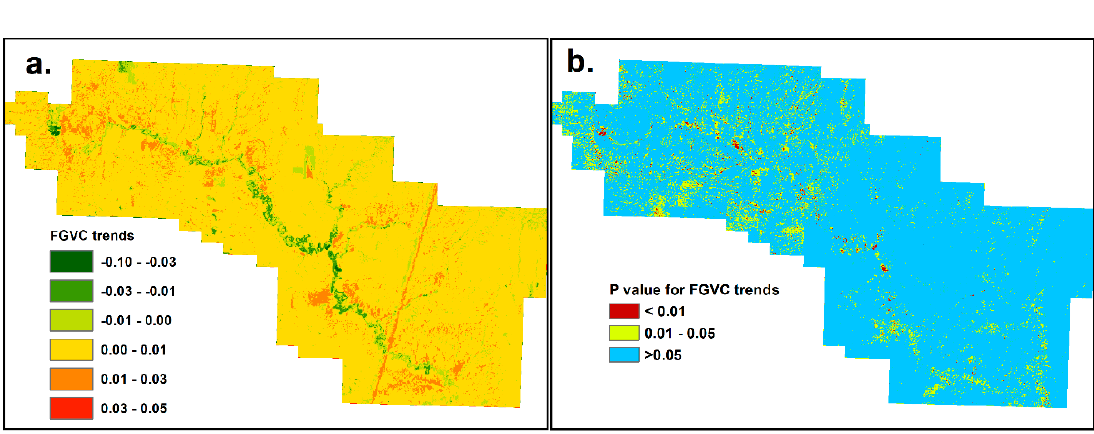
Figure 11. FGVC trend over the study period (a) and their significant level (b).